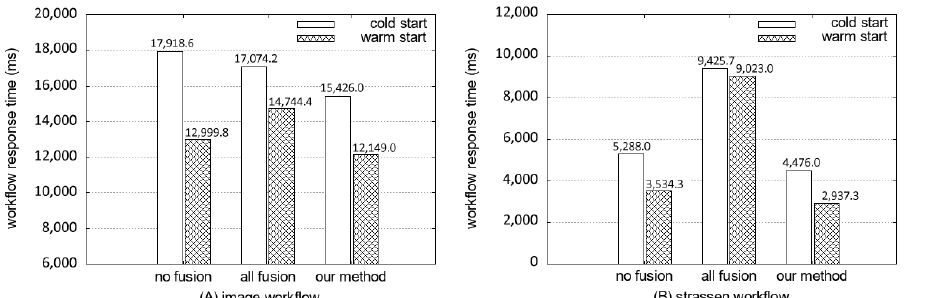
Figure 11. Workflow response time on the cold start and the warm start of the original workflow, all functions fused workflow, and the workflow fused by our method (in real-word